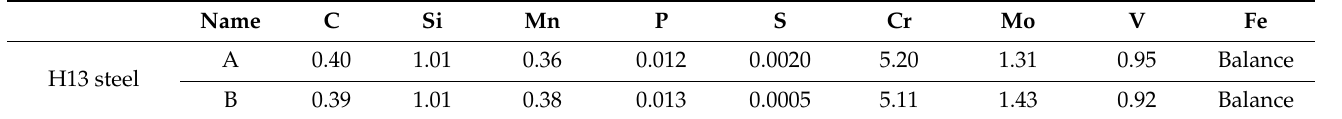
Table 1. Chemical compositions of the two H13 steels in weight